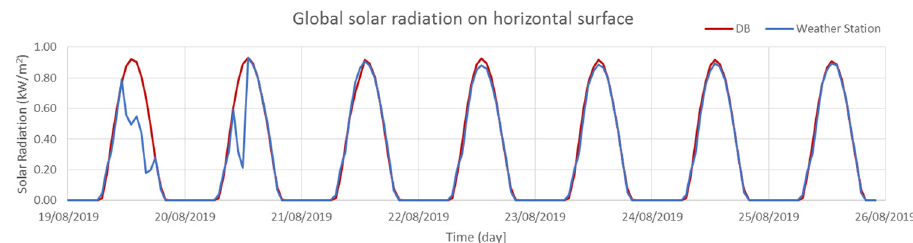
Figure 11. Solar radiation intensity on a horizontal surface recorded by the weather station and from the DB climate data file for the Cyprus simulations.